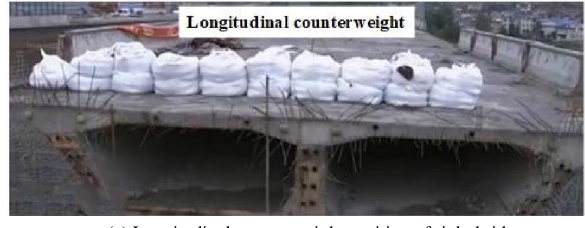
Figure 13. Longitudinal counterweight.